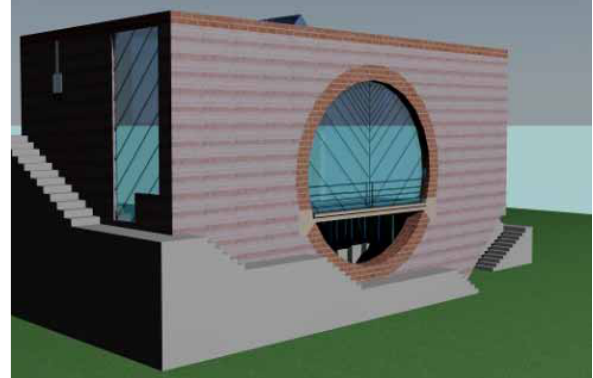
Figure 11. 3D Model of Single-family house in Massagno, Switzerland. Figure 13. Views of the digital model regarding the baldachin (Basilica of San Pietro in Vincoli in Rome).